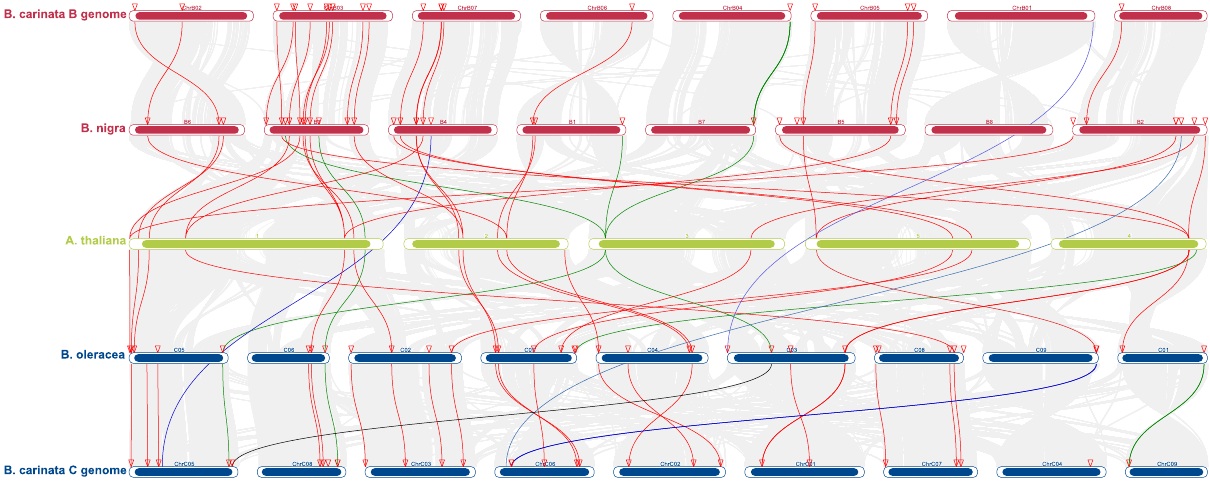
Figure 3. The s ynteny analysis among the AA, BB, and CC genomes of Brassicaceae family. The red bars are depicting BB chromosomes of B. carinata, and B. nigra , the green bars are of A. thaliana (AA), and the blue bars are for CC chromosomes of B. carinata and B. oleracea . The grey strings depict the collinear blocks, red and green lines are indicating orthologues identified in KCS and ELO genes and the blue and black lines are indicating possible translocations of KCS and ELO